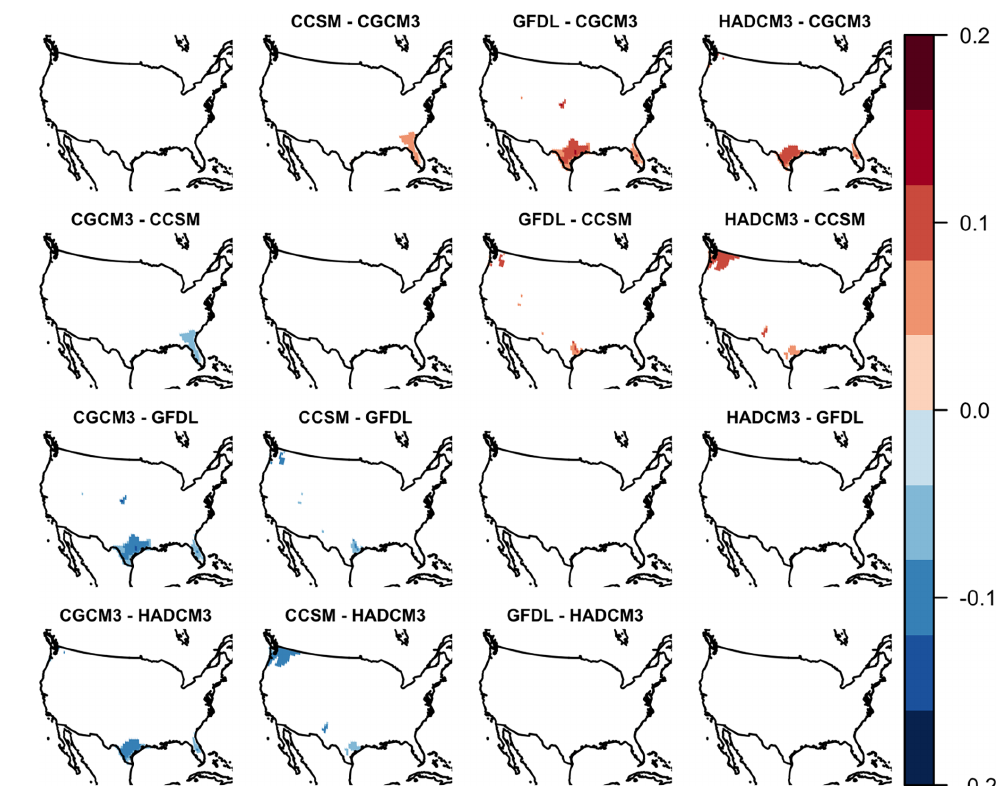
Figure 15. A heat map of the estimated average pairwise difference in rate of temperature change for GCM effects for the ASL model. Only significant locations at the 0.10 level using the CoPE method are